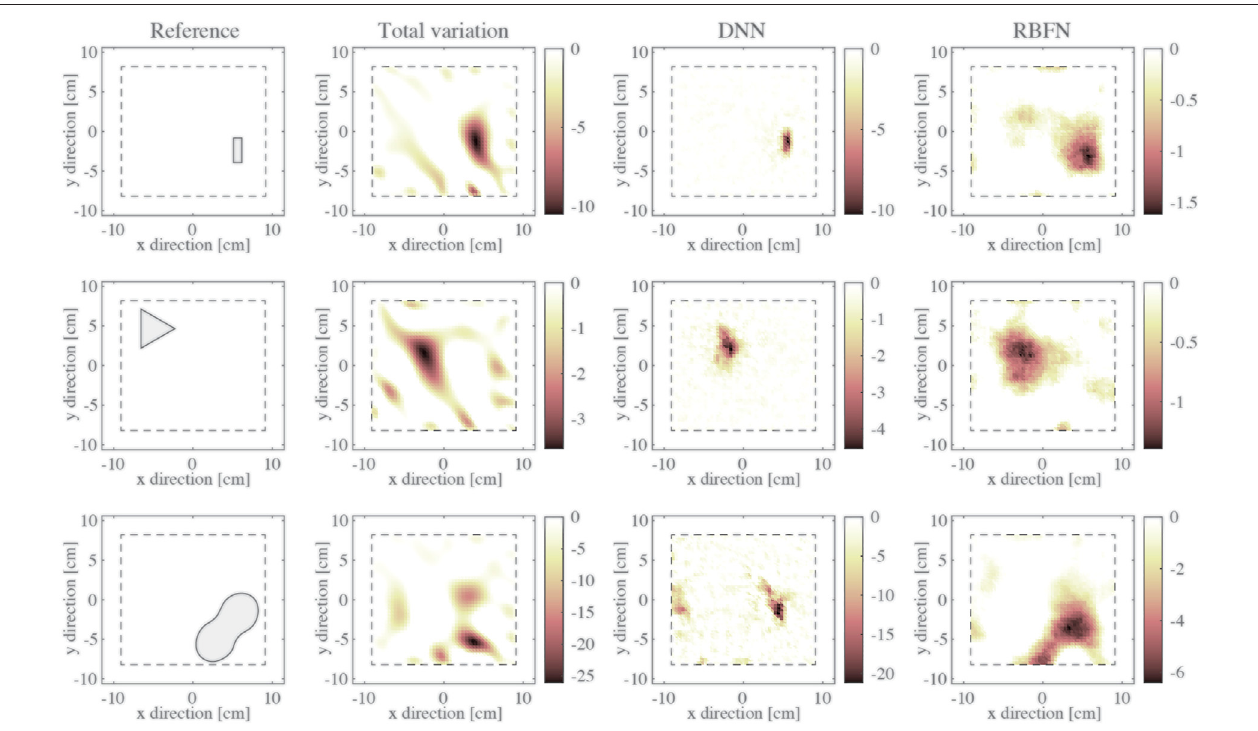
FIGURE 7 | Conductivity distributions obtained for Test